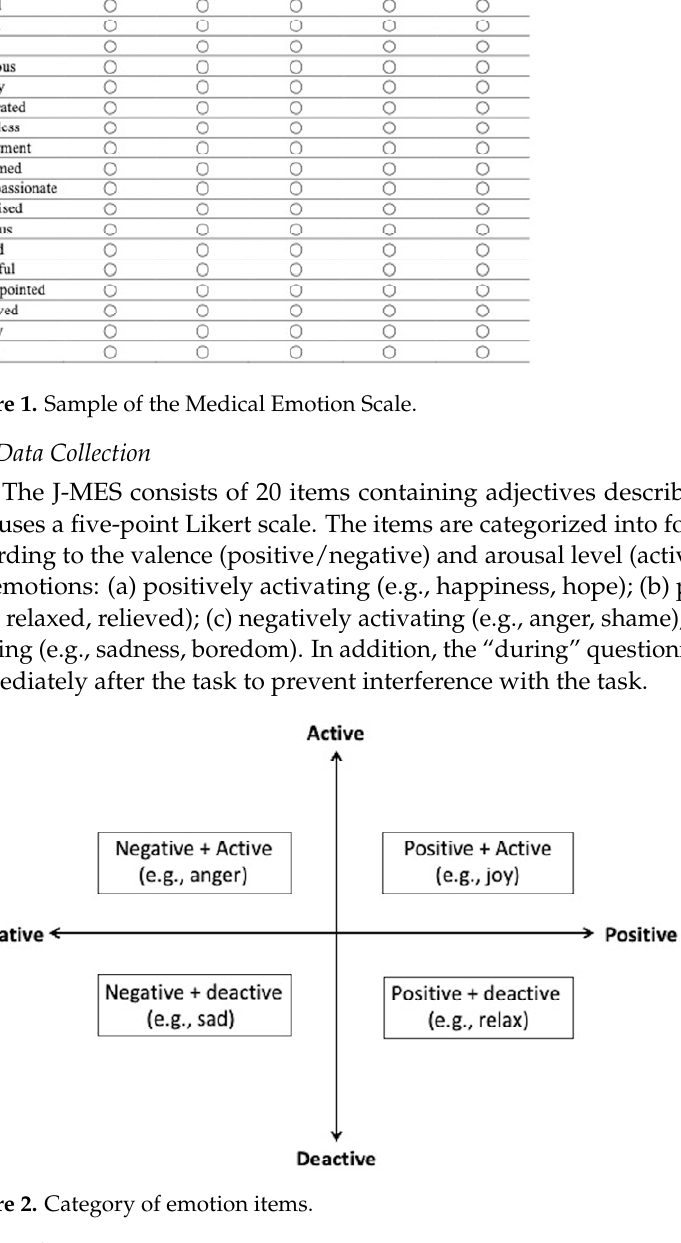
Figure 1. Sample of the Medical Emotion Scale